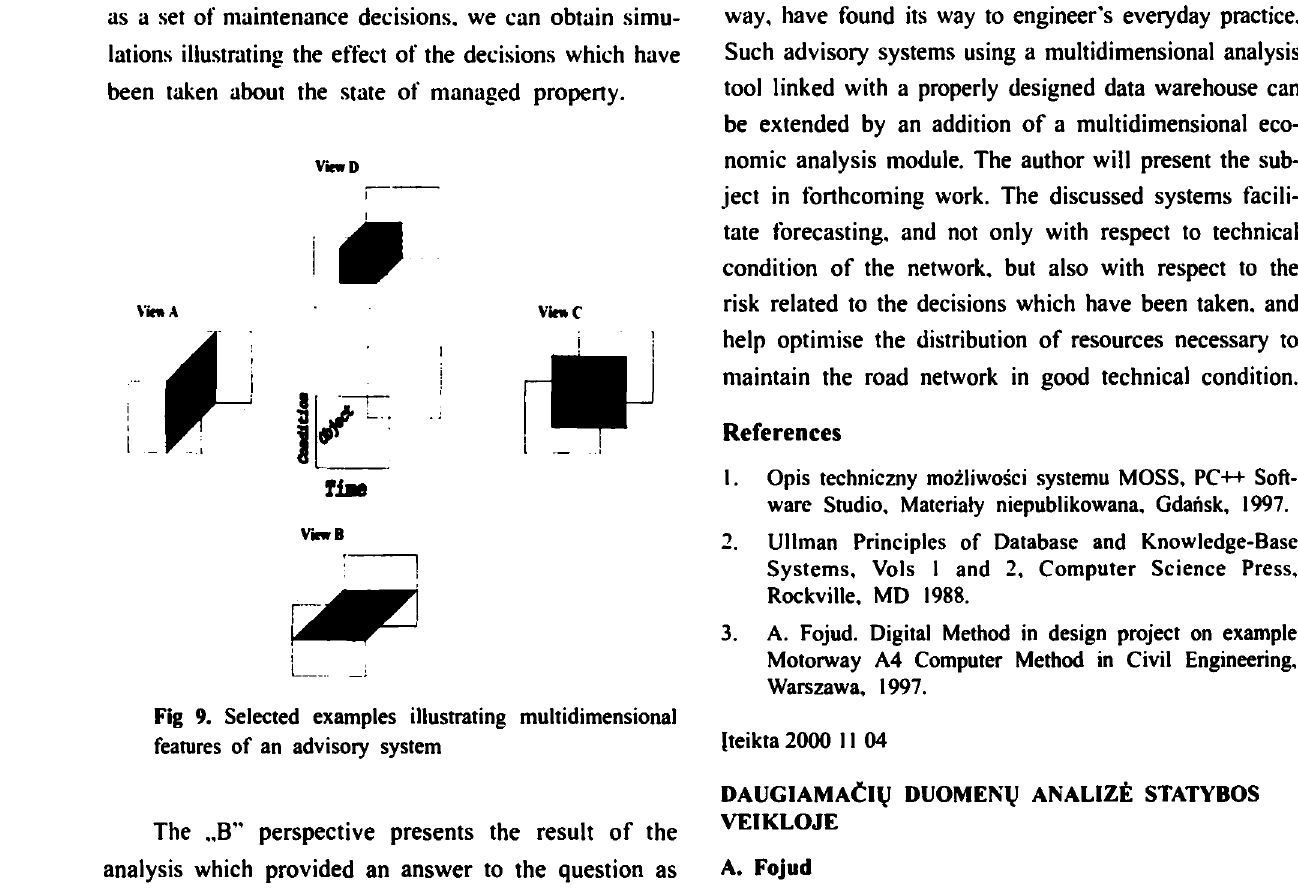
Fig 9. Selected examples illustrating multidimensional features of an advisory system